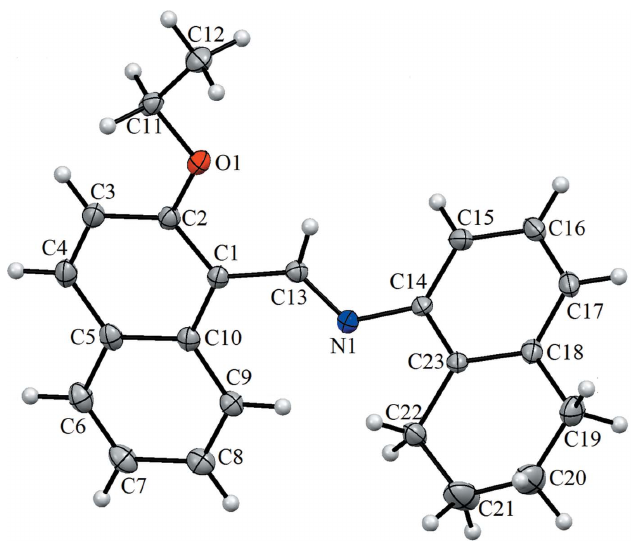
Figure 1 The molecular structure of the title compound, showing the atom labelling. Displacement ellipsoids are drawn at the 20% probability level.